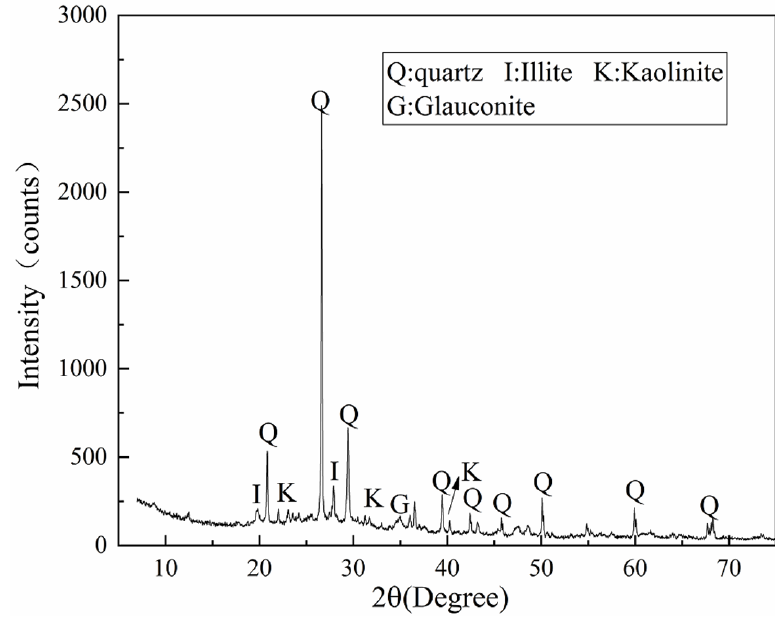
Figure 1. The XRD pattern of dredged sediment.